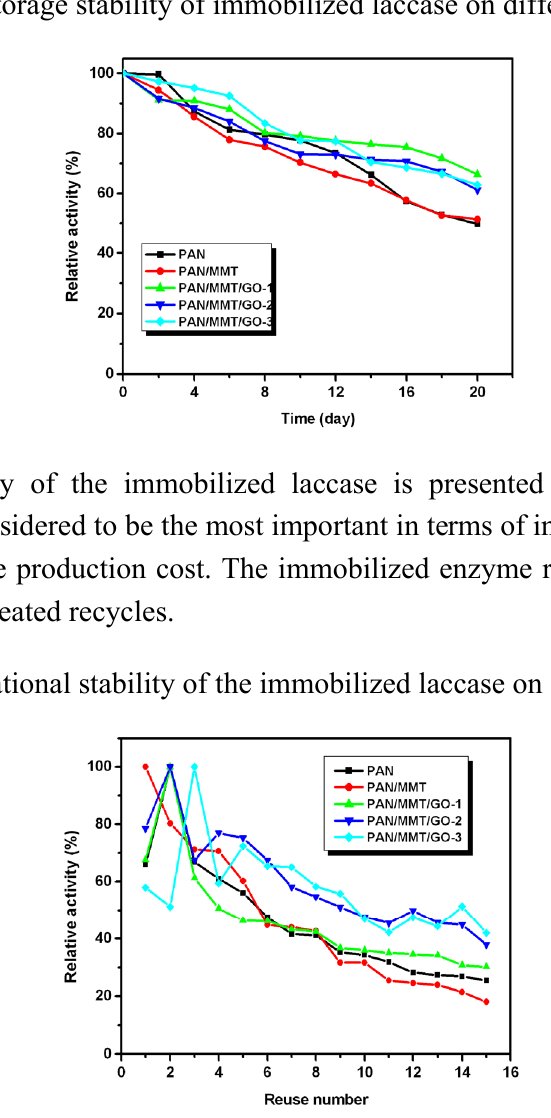
Figure 7. Storage stability of immobilized laccase on different supports.